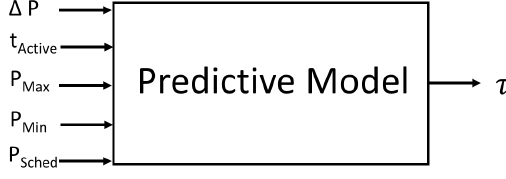
Figure 2. Data input and output of the predictive model.